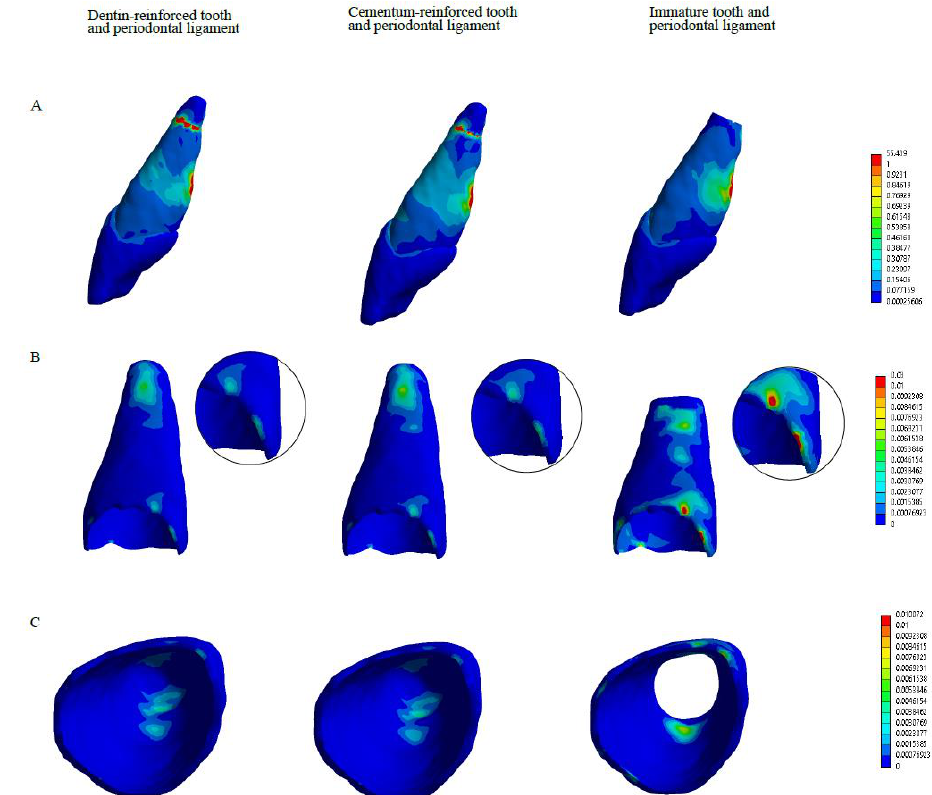
Figure 5. Stress distribution in the tooth ( A ) and in the periodontal ligament ( B , C ) of Models 1, 2 and 3 in the rotation scenario. Similar stress patterns are observed between all tissues of Models 2 and 3. Maximum tensile stress of the teeth ( A ) and ligaments ( B , C ) are coloured in red.